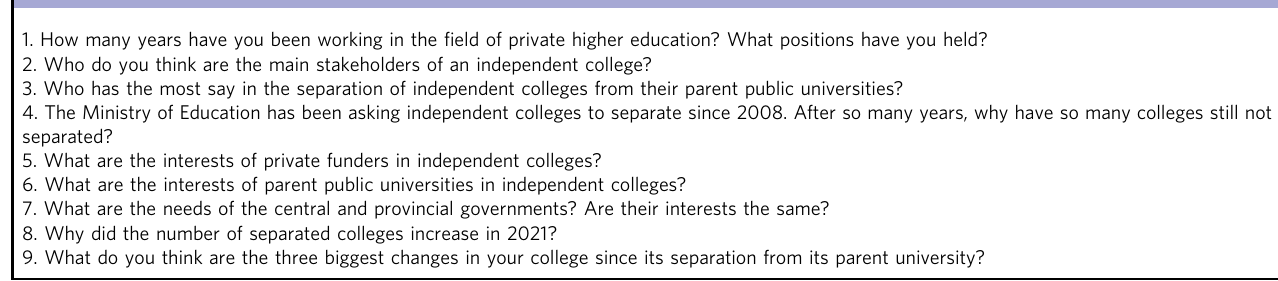
Table 2 Interview questions of the